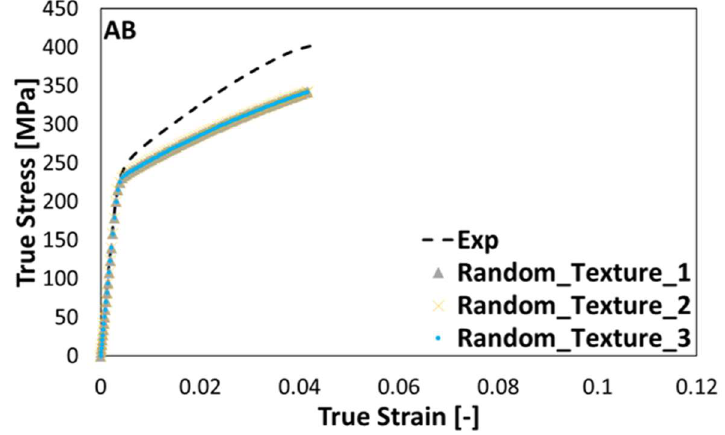
Figure A1. Comparison of the experimental and the predicted tensile behavior of the PBF-LB/M AlSi10Mg AB state using the RVEs with randomly generated orientations.